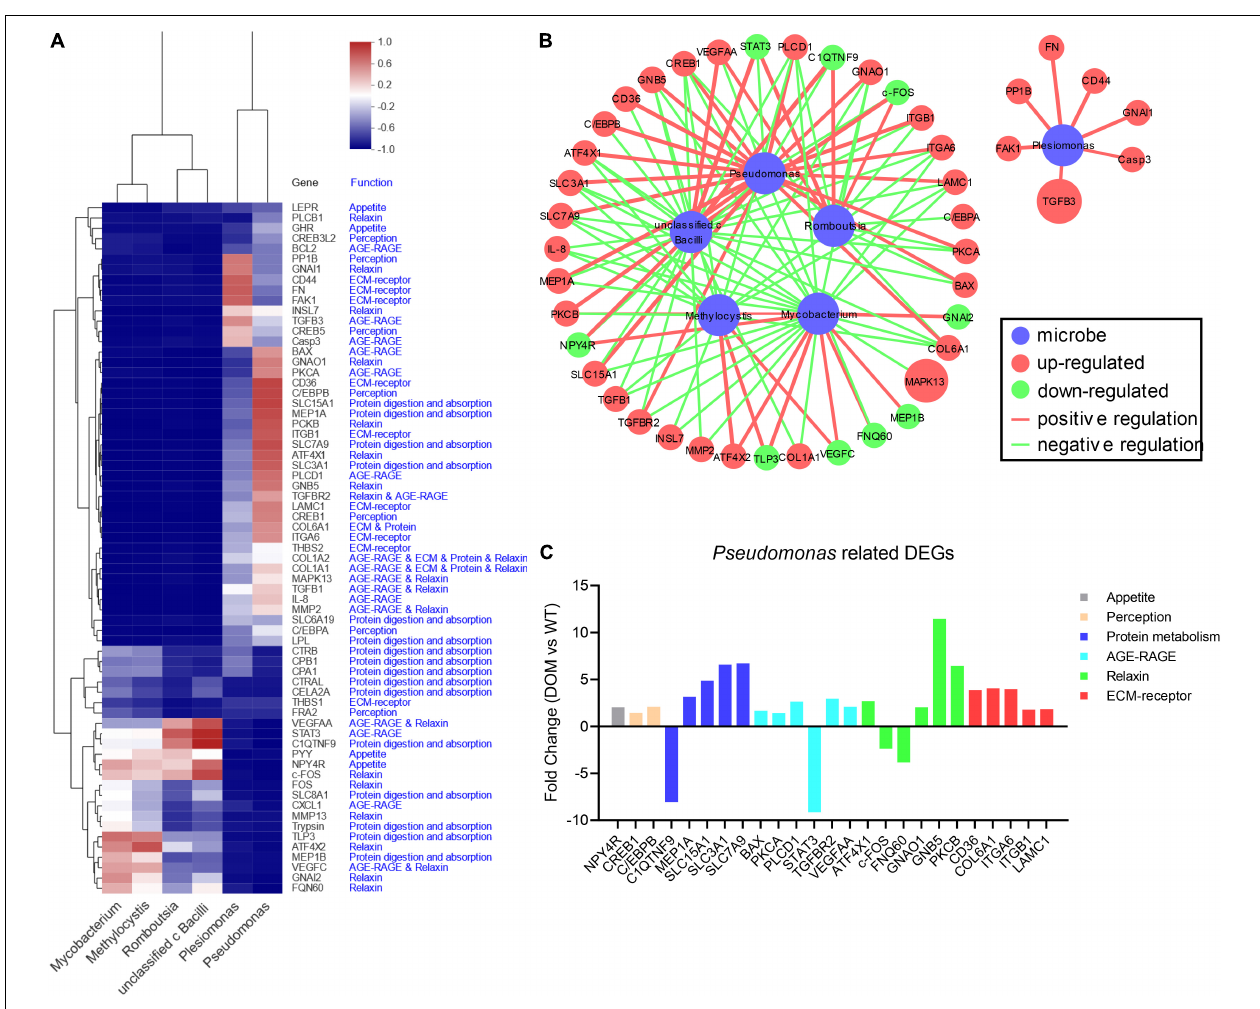
FIGURE 7 | Integrated analysis between DEGs and microbes under feed domestication in A. grunniens . (A) Heatmap cluster between key microbes at genus level and enriched genes. (B) Interacting regulatory network between key microbes and key enriched genes. In the network, nodes in red color represent the upregulated DEGs, in green color represent the downregulated DEGs, in blue color represent the microbes. The size of a node represents the mRNA abundance retrieved from RNA-seq, and the width of the connecting line represents the correlation intensity between DEGs and microbes. (C) Transcriptome profiles of Pseudomonas -mediated DEGs relate to appetite, perception, protein digestion and absorption (protein metabolism), AGE-RAGE, relaxin, and ECM–receptor